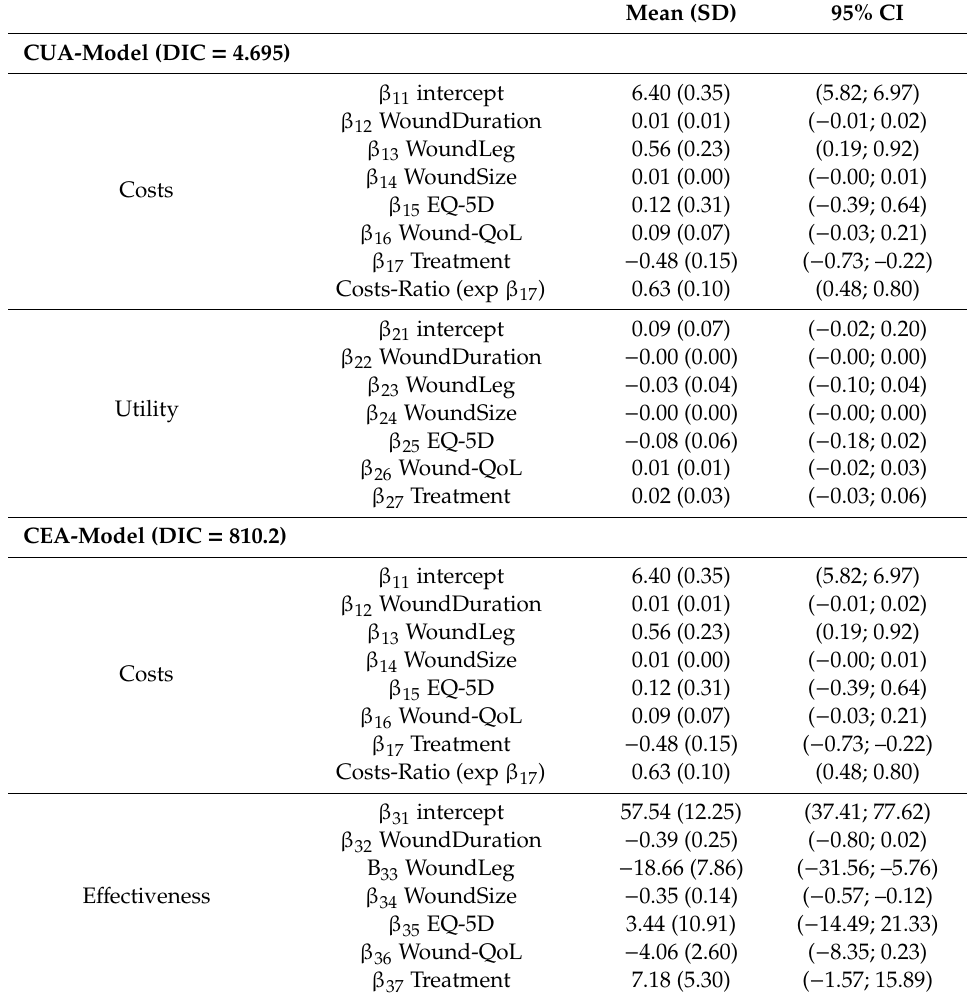
Table 5. Estimations of the posterior distribution of the β coe ffi cients for the cost-utility and cost-e ff ectiveness analysis (100,000 simulations